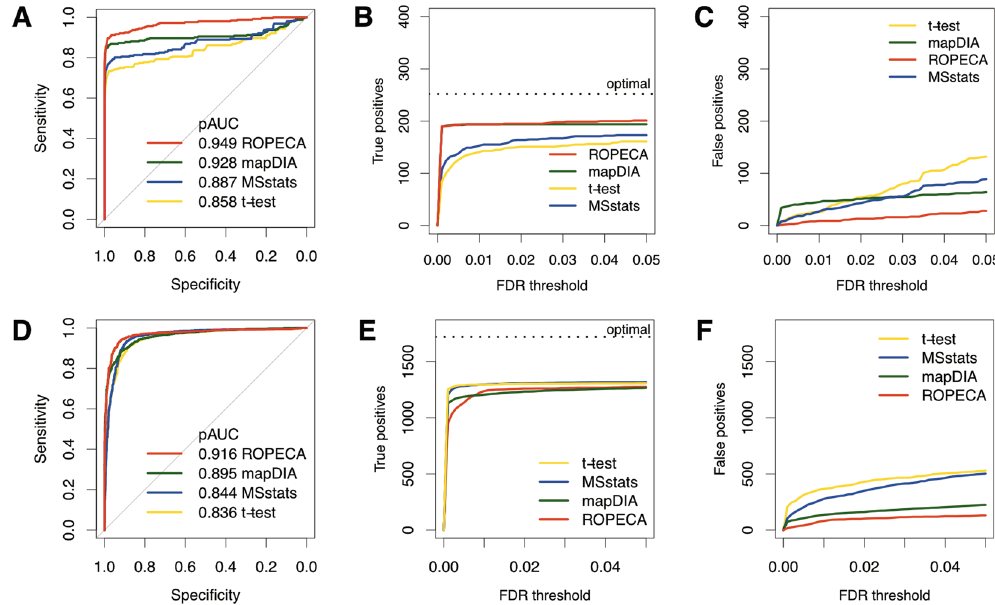
Figure 2. Performance of ROPECA in two diverse benchmark data sets. ( A) Receiver operating characteristic (ROC) curves of the different statistical methods in the DIA profiling standard data. The ROC curves were produced by merging the individual results of all pairwise comparisons. The partial area under the curve (pAUC) for specificity above 0.9 is shown for each method. ( B , C) Number of true positives and false positives in the DIA profiling standard as a function of false discovery rate (FDR) threshold. The black dotted line represents optimal performance. ( D) ROC curves in the hybrid proteome benchmark data. ( E,F ) Number of true positives and false positives in the hybrid proteome benchmark data as a function of FDR threshold. The black dotted line represents optimal performance.